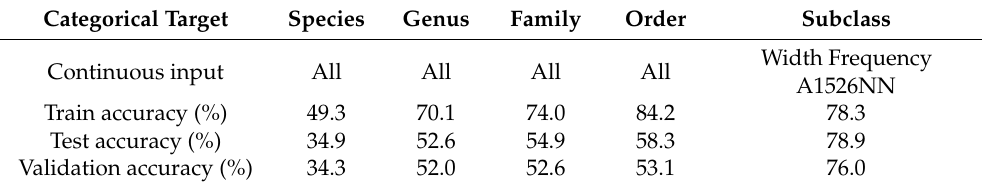
Table 2. Categorical target, continuous input variables and data set accuracy of the Artificial Neuronal Network (ANN) models with the highest accuracy in the test series. The network architecture used was Multilayer Perceptron (MLP). The accuracy classes considered were those proposed by the European Centre for the Validation of Alternative Methods [56]: sufficient accuracy (65–74%); good accuracy (75–84%); excellent accuracy